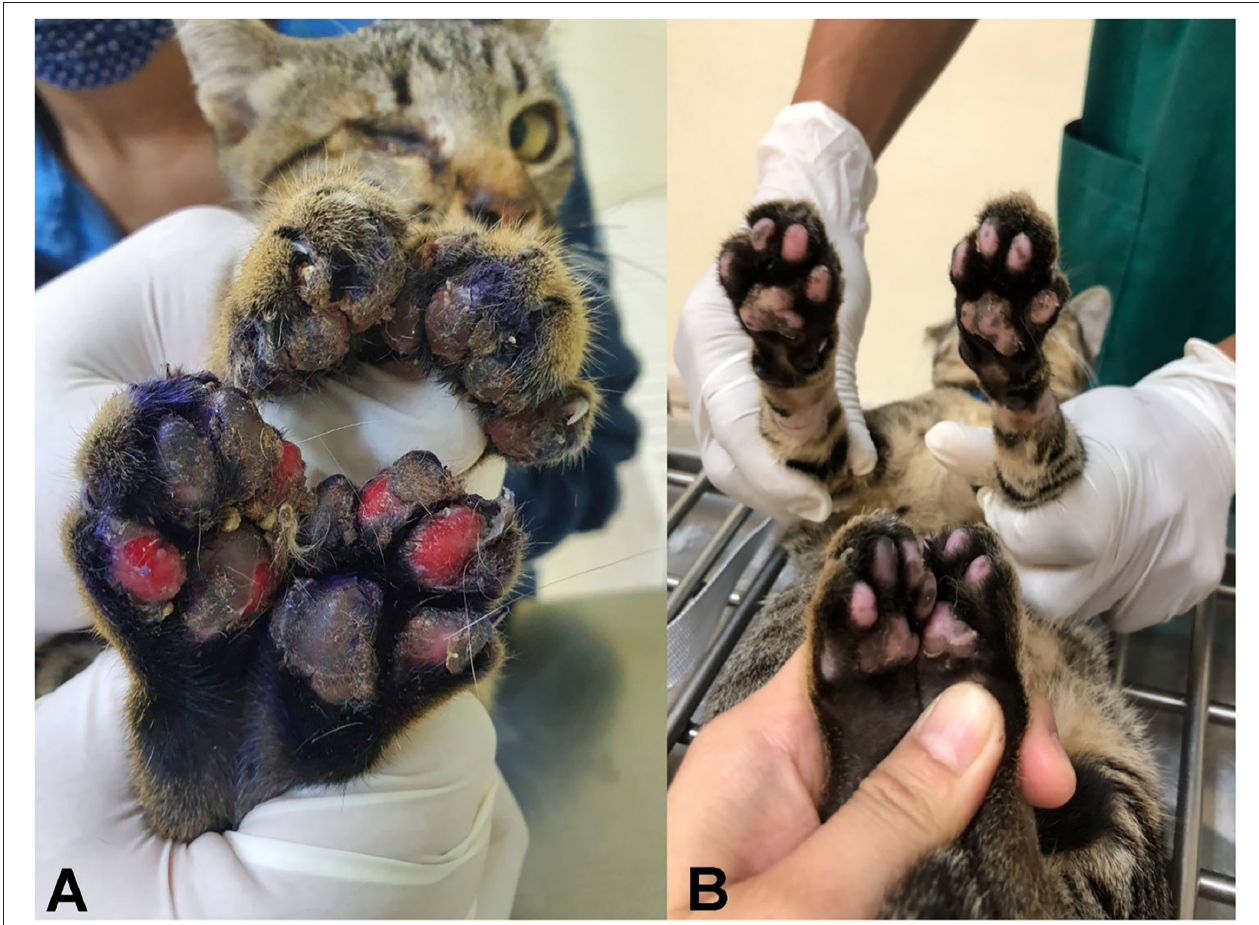
FIGURE 1 | Ulcerative pododermatitis caused by Anatrichosoma spp. was presented in four feet (A) ; 2 weeks post-treatment with emodepsine/praziquantel led to complete recovery (B)